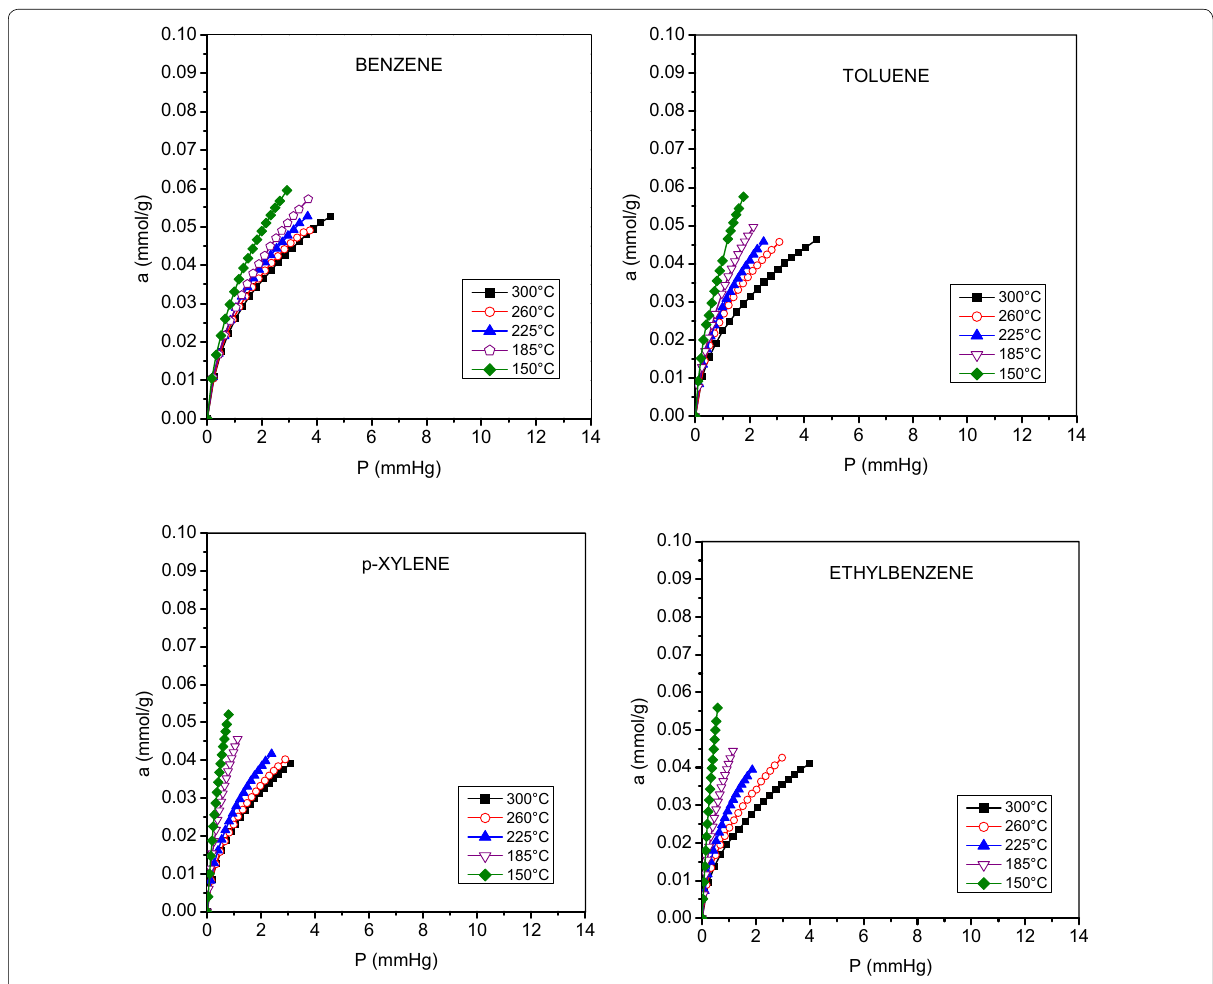
Fig. 3 Benzene, toluene, p ‑xylene, and ethylbenzene adsorption isotherms for